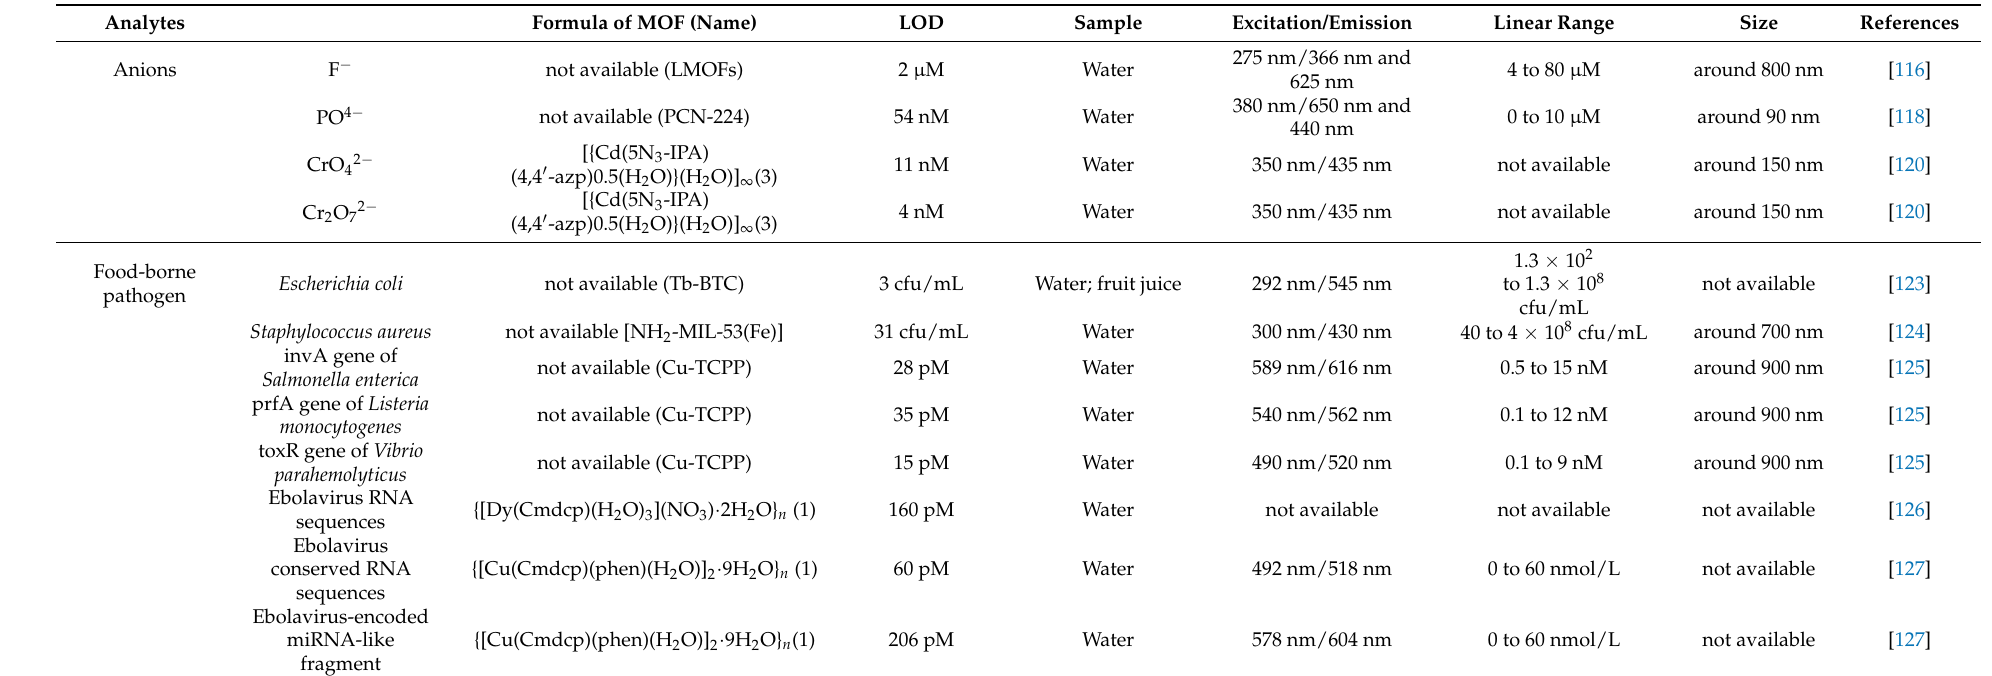
Table 4. A summary of representative examples of NMOFs for food